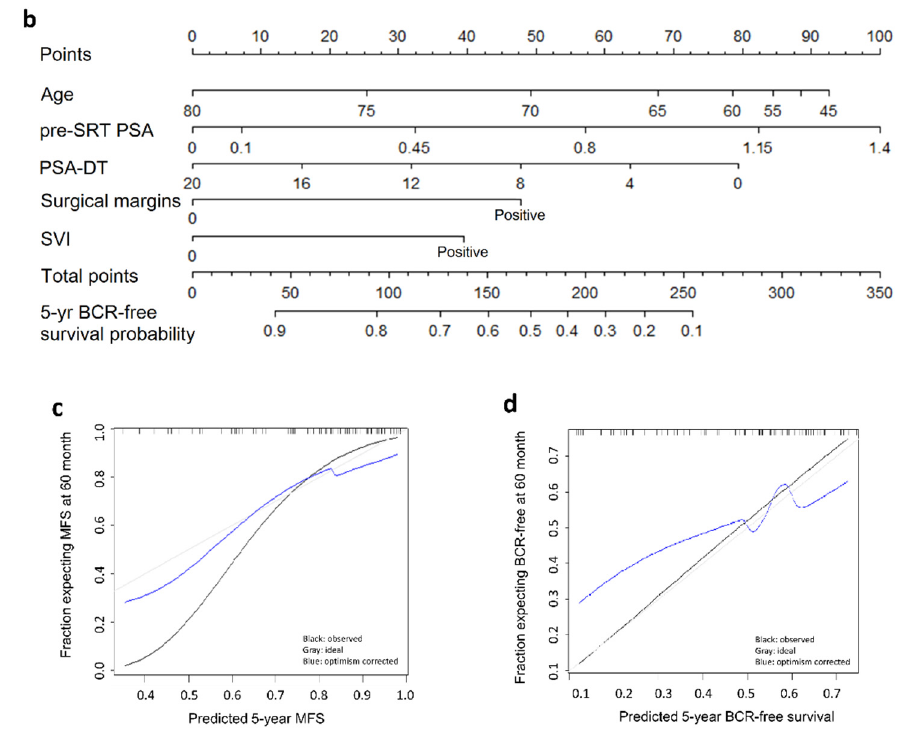
Figure 3. Nomogram to predict the 5-year ( a ) biochemical recurrence (BCR)-free probability and ( b ) metastasis-free (MSF) probability following salvage radiotherapy (SRT) for BCR after radical prostatectomy based on age at SRT, pre-SRT PSA level, PSA-doubling time (PSA-DT), surgical margins, and seminal vesicle invasion (SVI). Calibration of the nomogram for 5-year ( c ) BCR-free probability and ( d ) MSF probability.